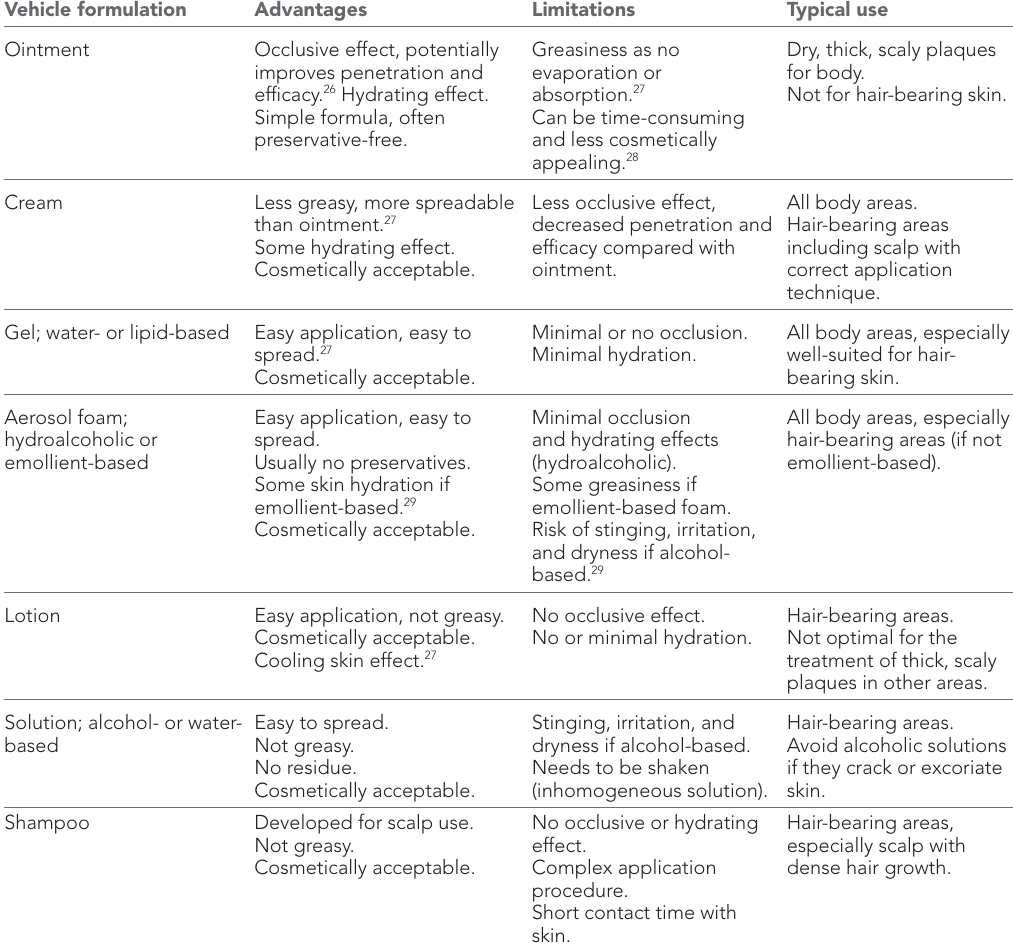
Table 3 Advantages, limitations, and practical considerations of the most commonly used